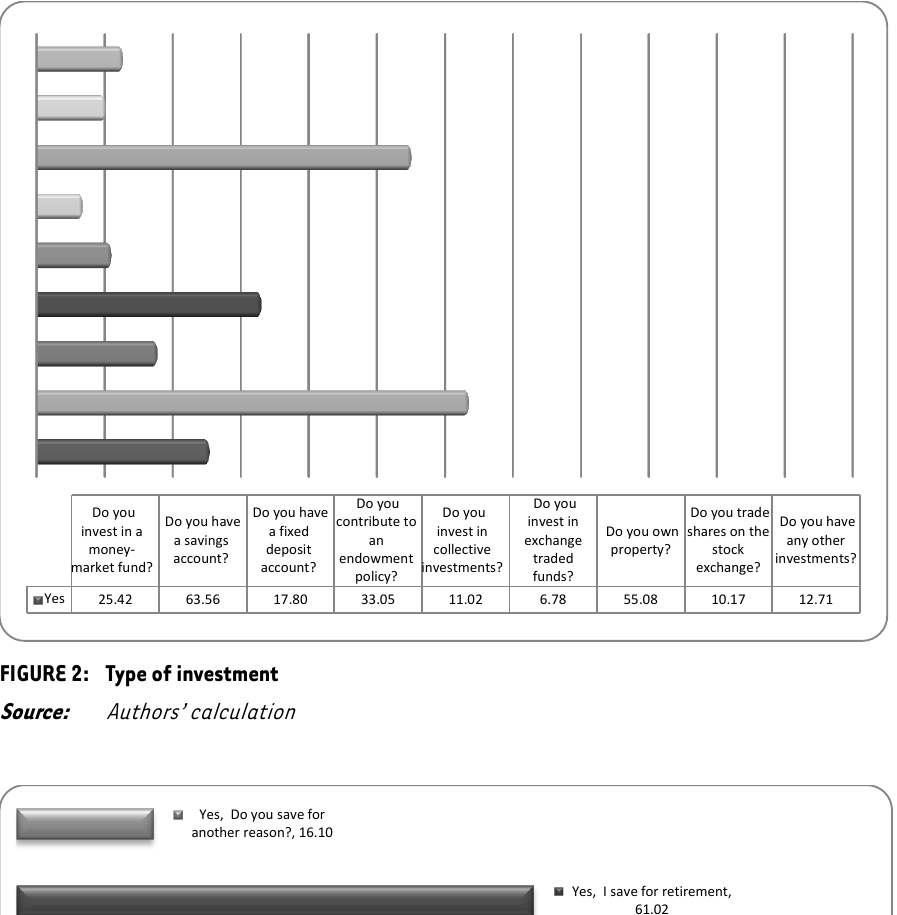
FIGURE 2: Type of investment Source: Authors’ calculation